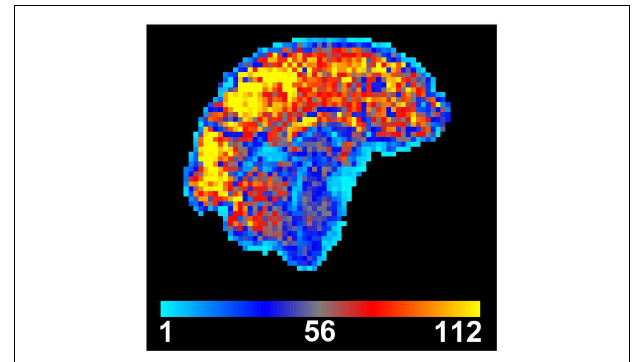
FIGURE 1 |Temporal signal to noise (tSNR) map created from motion-corrected resting BOLD time series image data . tSNR is dramatically reduced in the brainstem when compared to other brain areas. Data were acquired from a single subject at 3T using a 32-channel head coil, with 3mm isotropic resolution, 100 time points,TE/TR = 30/3000ms, flip angle = 90 ° , and acceleration factor